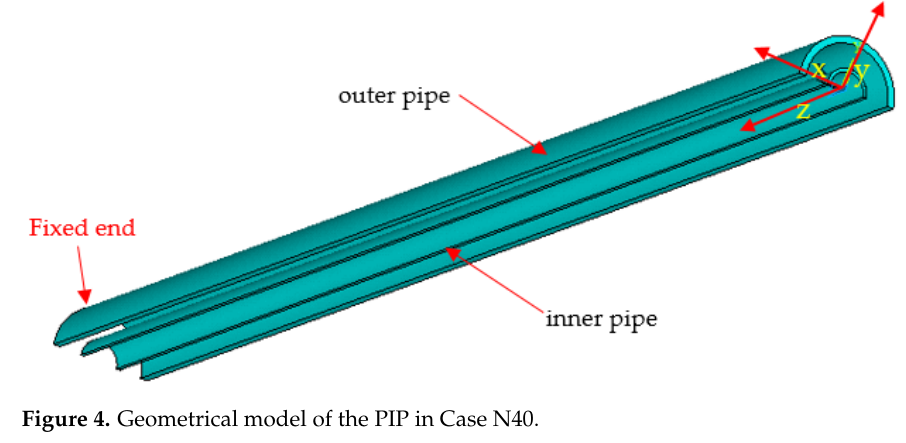
Figure 4. Geometrical model of the PIP in Case N40.